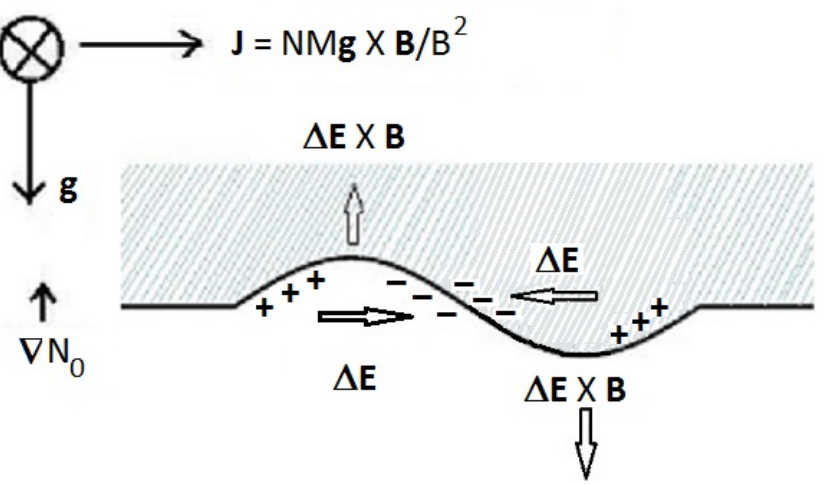
Figure 6. In this schematic figure, the shaded region represents the equatorial F layer, with higher plasma density, resting over a lower plasma density region (unshaded). The geomagnetic field is horizontal and northward (into the page). A gravitational current flows in the eastward direction. In the presence of a perturbation in plasma density on the bottom side of the F layer, perturbation electric fields ∆ E develop. Motion of the plasma in the ∆ E × B direction due to the perturbative electric fields is indicated by upward and downward